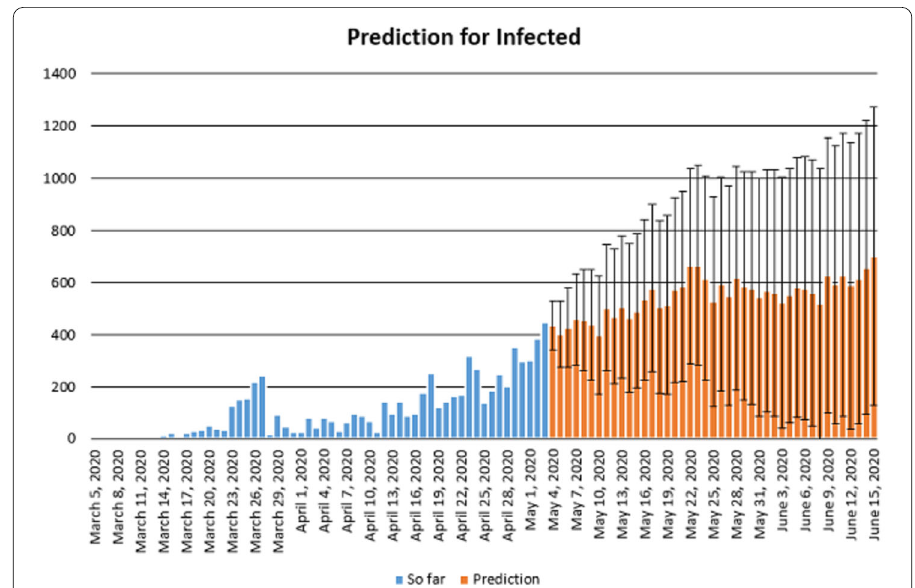
Figure 29 Prediction of daily number of infected in South Africa using forecast sheet with reliability level of 90%